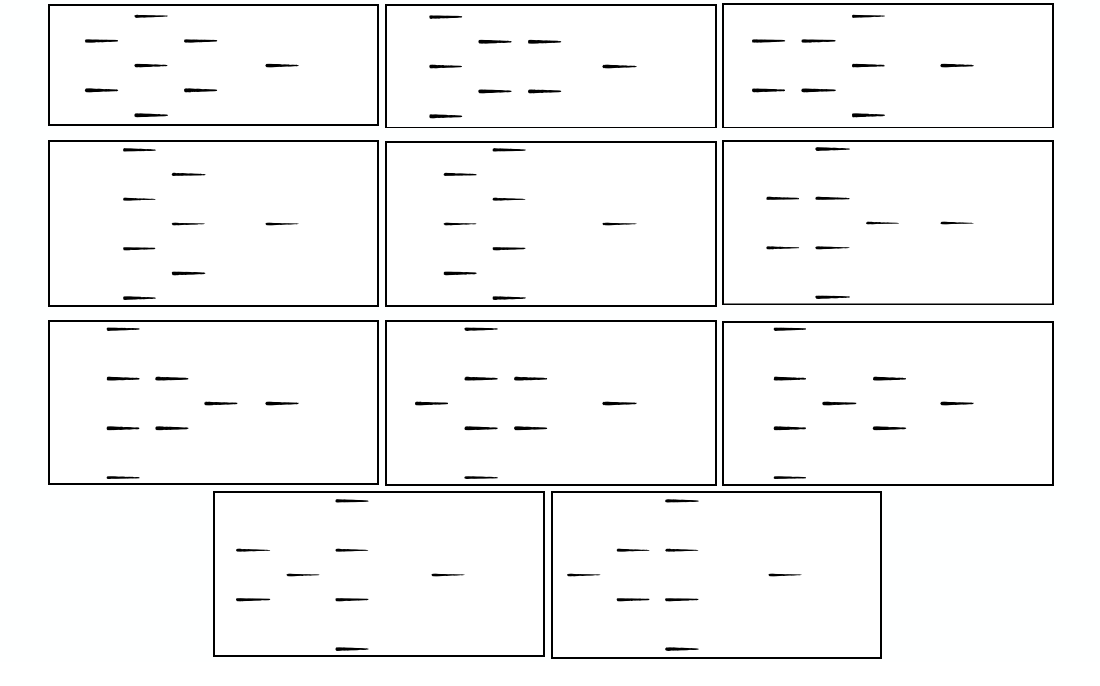
Figure A6. Configurations for seven leading swimmers.